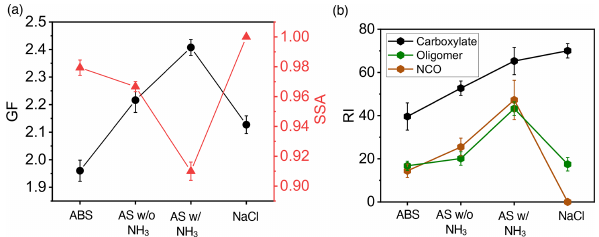
Figure 3. Dependence of SOA/BrC formation on seed parti- cles. (a) GF (black) and SSA (red) at 120min of exposure for (NH 4 ) 2 SO 4 particles in the presence (AS w/ NH 3 ) and absence (AS w/o NH 3 ) of 19ppbNH 3 and for NH 4 HSO 4 (ABS) and NaCl parti- cles in the absence of NH 3 . (b) Aerosol-phase relative intensity (RI) for carboxylates (black), oligomers (green), and NCOs (brown) on different seed particles. The error bar denotes 1 σ of three replicated measurements. All particle properties were measured relevant to dry conditions (less than 5%RH) and were dominantly contributed by non-volatile aerosol-phase